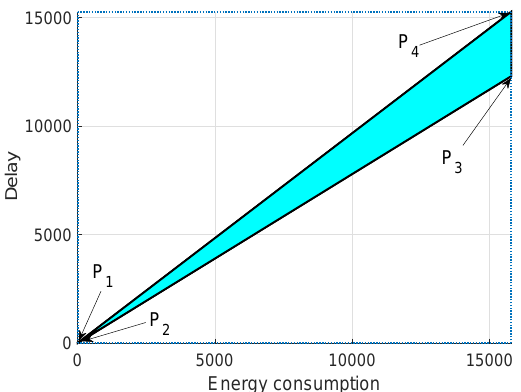
Figure 17. Feasible region for energy consumption and delay using GEDPAR.